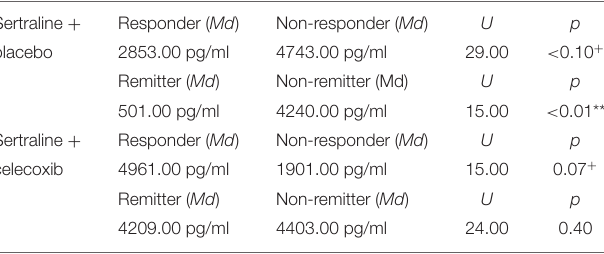
TABLE 4A | Comparison of baseline MIF levels of different response statuses in the two treatment arms.